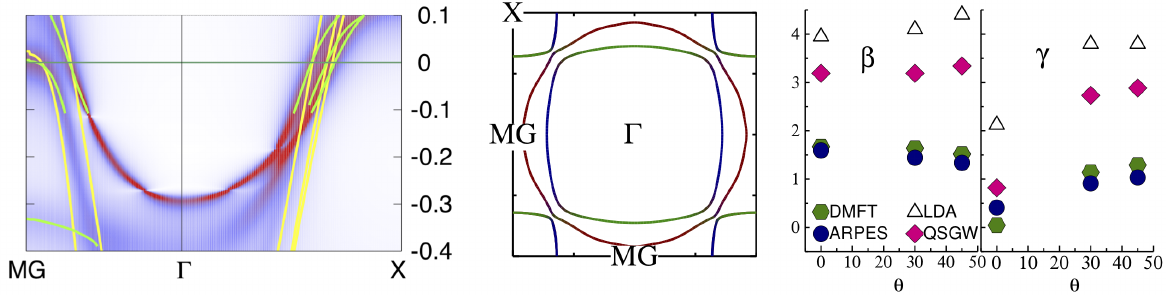
Figure 1. Dynamical mean field theory (DMFT) spectral function in Sr 2 RuO 4 at 145K (left). Yellow lines are QS GW bands; green lines extract the peak in the QS GW ++ spectral functions near the Fermi level. The middle panel shows the QS GW Fermi surface, showing the inner ( β ), middle ( γ ), and outer ( α ) pockets resolved by the orbital character (red = xy , green = xz , blue = yz ). Point MGis midway between the M and Γ points. QS GW , QS GW ++ , and ARPESFermi surfaces are all very similar, with QS GW ++ being slightly closer to the ARPES measurement. The right figure shows the Fermi velocities v F (10 5 m/s) of the β and ( γ ) pockets, on a line connecting q = 0 to a zone boundary point, whose direction is given by ( cos ( θ ) ,sin ( θ ))